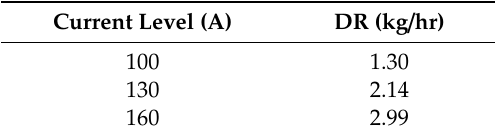
Table 2. Interpolated values of deposition rate (DR d ) for di ff erent